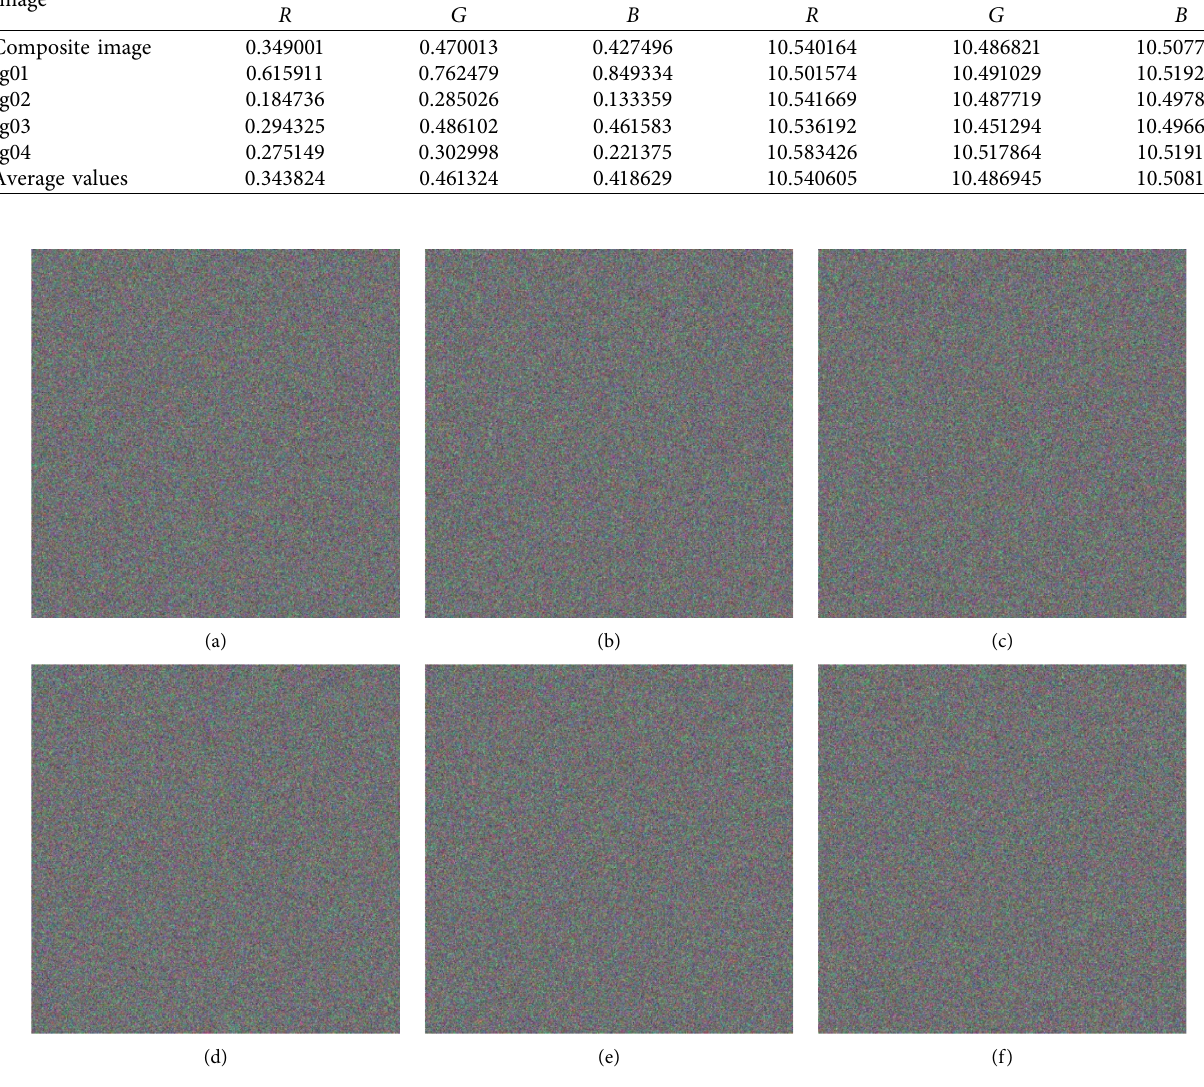
Figure 10: Decryption process for the cipher composite image (Figure 4(b)) for different alterations to secret key parameters. (a) Actual key with alteration at V � 303. (b) Actual key with alteration at t � 324. (c) Actual key with alteration at µ � π /2. (d) Actual key with alteration at